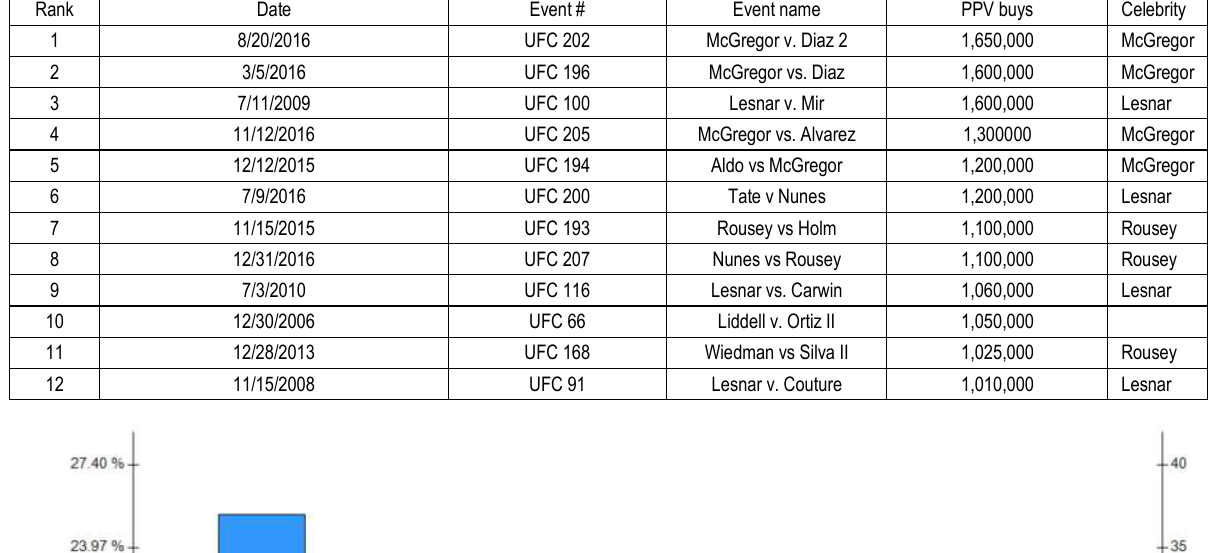
Table 3. Top 12 UFC pay-per-view events